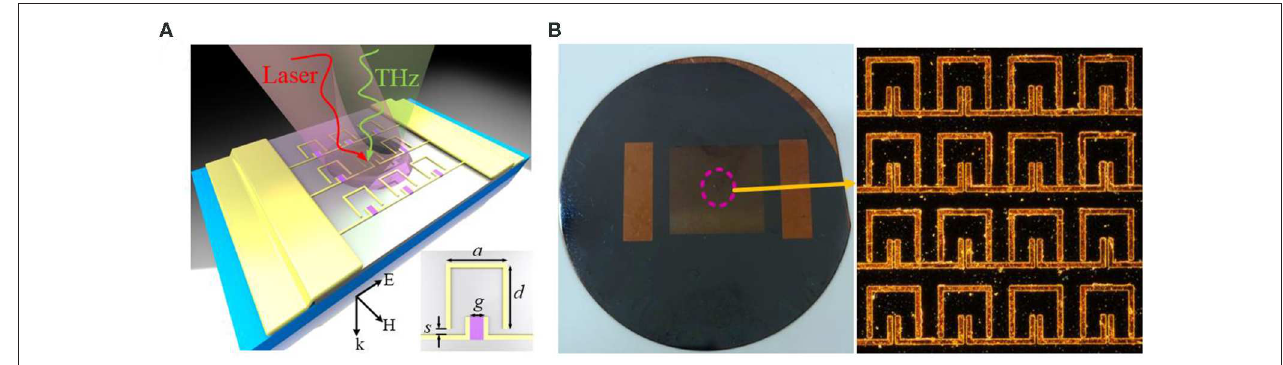
FIGURE 1 | (A) Three-dimensional schematic diagram of the proposed metasurface embedded with perovskite quantum dots (CsPbBr 3 -QDs). (B) Optical microscope image of the fabricated CsPbBr 3 -QD-embedded metasurface (geometric parameters of the metasurface unit cell, a and d 70 µ =